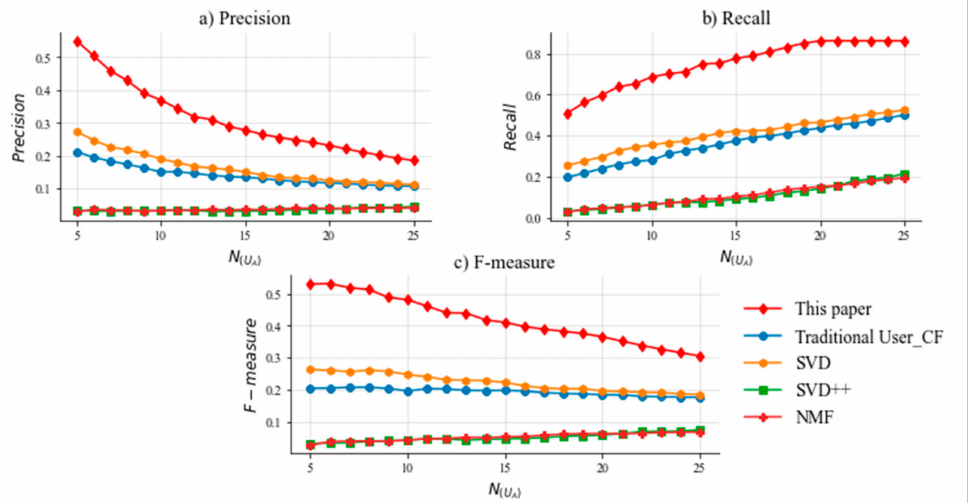
Figure 5. The comparison results of the proposed ReRec algorithm (the combination of ReRec-ASI and ReRec-AUSI) and four baselines on active